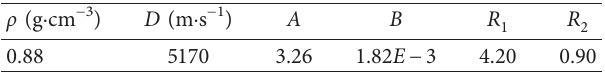
Figure 5: Structural model of roof cutting.